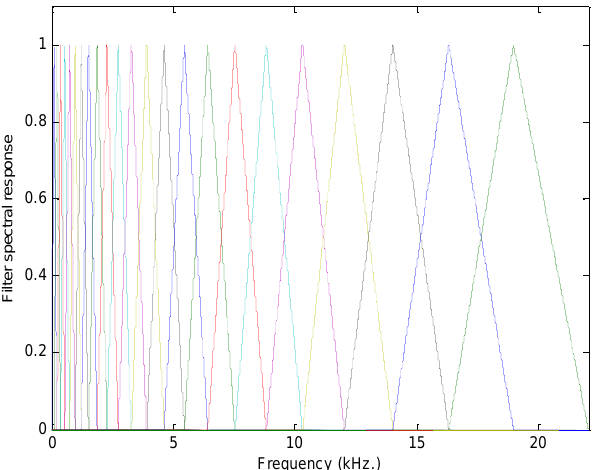
Figure 10. Spectral response of the 23 filter bank in conventional (frequency) scale.